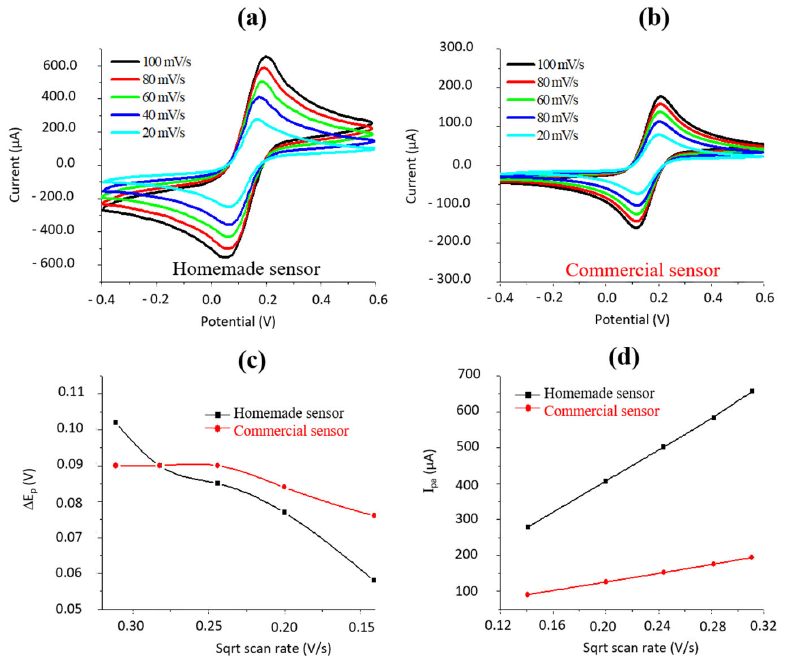
Figure 8. ( a , b ) Typical CV diagrams (using the Fe 3+ /Fe 2+ redox couple) as a function of the scan rate for ( a ) the homemade sensor and ( b ) the commercial one; ( c ) oxidation current; and ( d ) Δ Ep value versus the square root of the scan rate for both